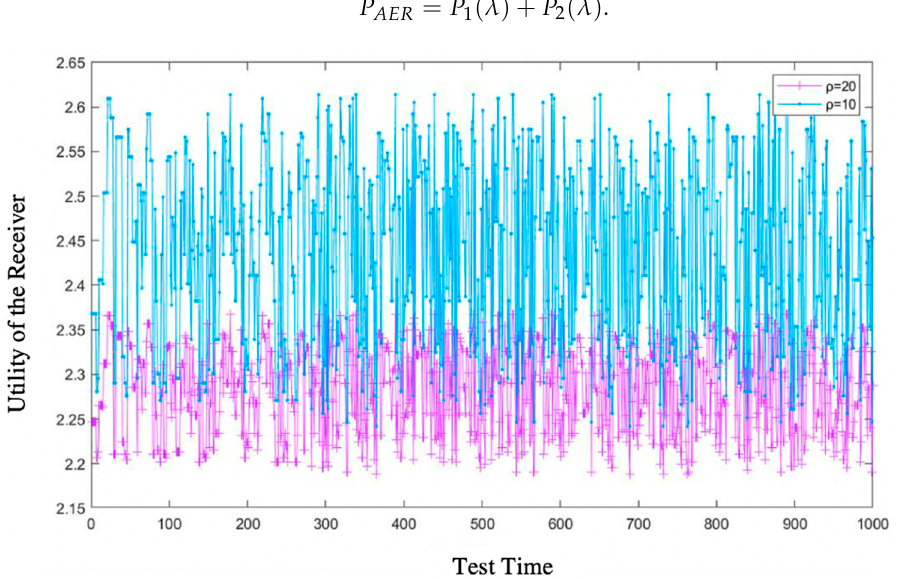
Figure 4. When 𝑘 = −3 , the change in the receiver gain is tested with the increase in the number of Figure 4. When k = − 3, the change in the receiver gain is tested with the increase in the number of experiments at 𝜌 = 20 and 𝜌 = 10 , respectively, and the experiment is tested 1000 times. experiments at ρ = 20 and ρ = 10, respectively, and the experiment is tested 1000